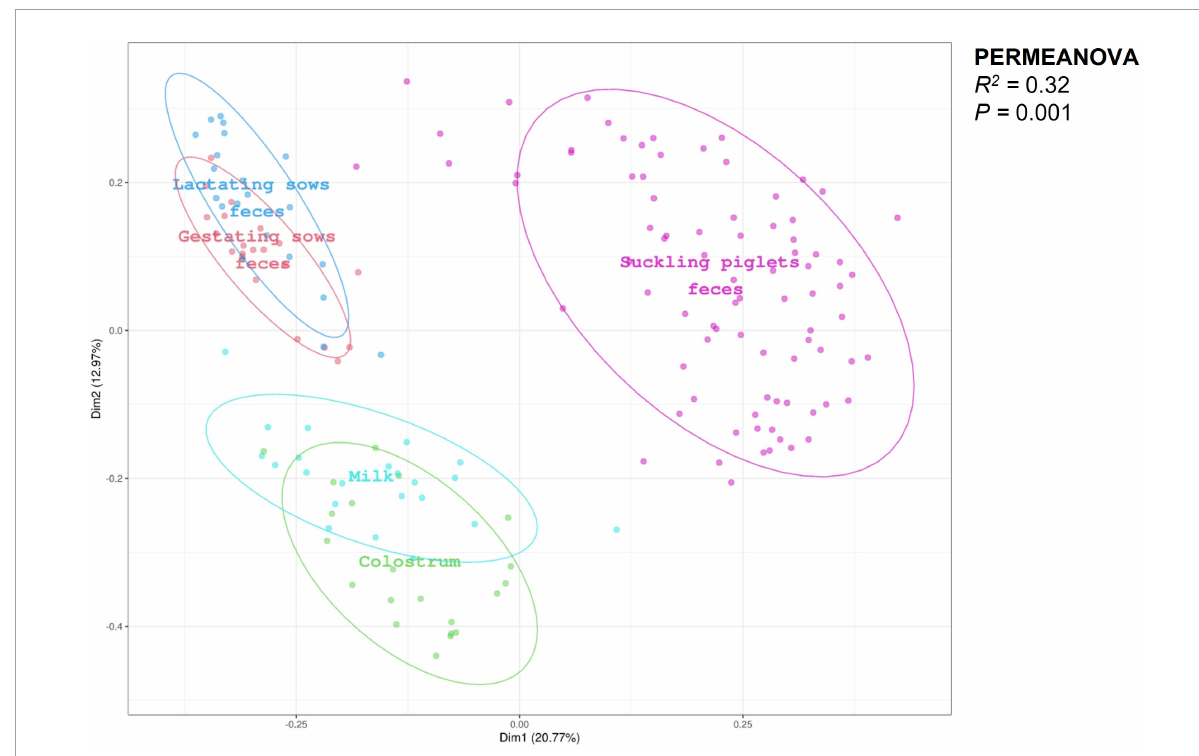
FIGURE1 Principal coordinates analysis (PCoA) plot of gestating and lactating sows’ feces ( n = 21, respectively), colostrum ( n = 21), milk ( n = 21), and suckling piglets’ feces ( n = 84), regardless of experimental dietary treatments, revealed distinct clusters for each sample type ( R 2 = 0.32; P = 0.001). PERMANOVA test performed using Bray–Curtis distances to analyze beta-dispersion showed differences between all the different types of samples analyzed (all P ≤ 0.037) except among gestating and lactating sows’ feces ( P =